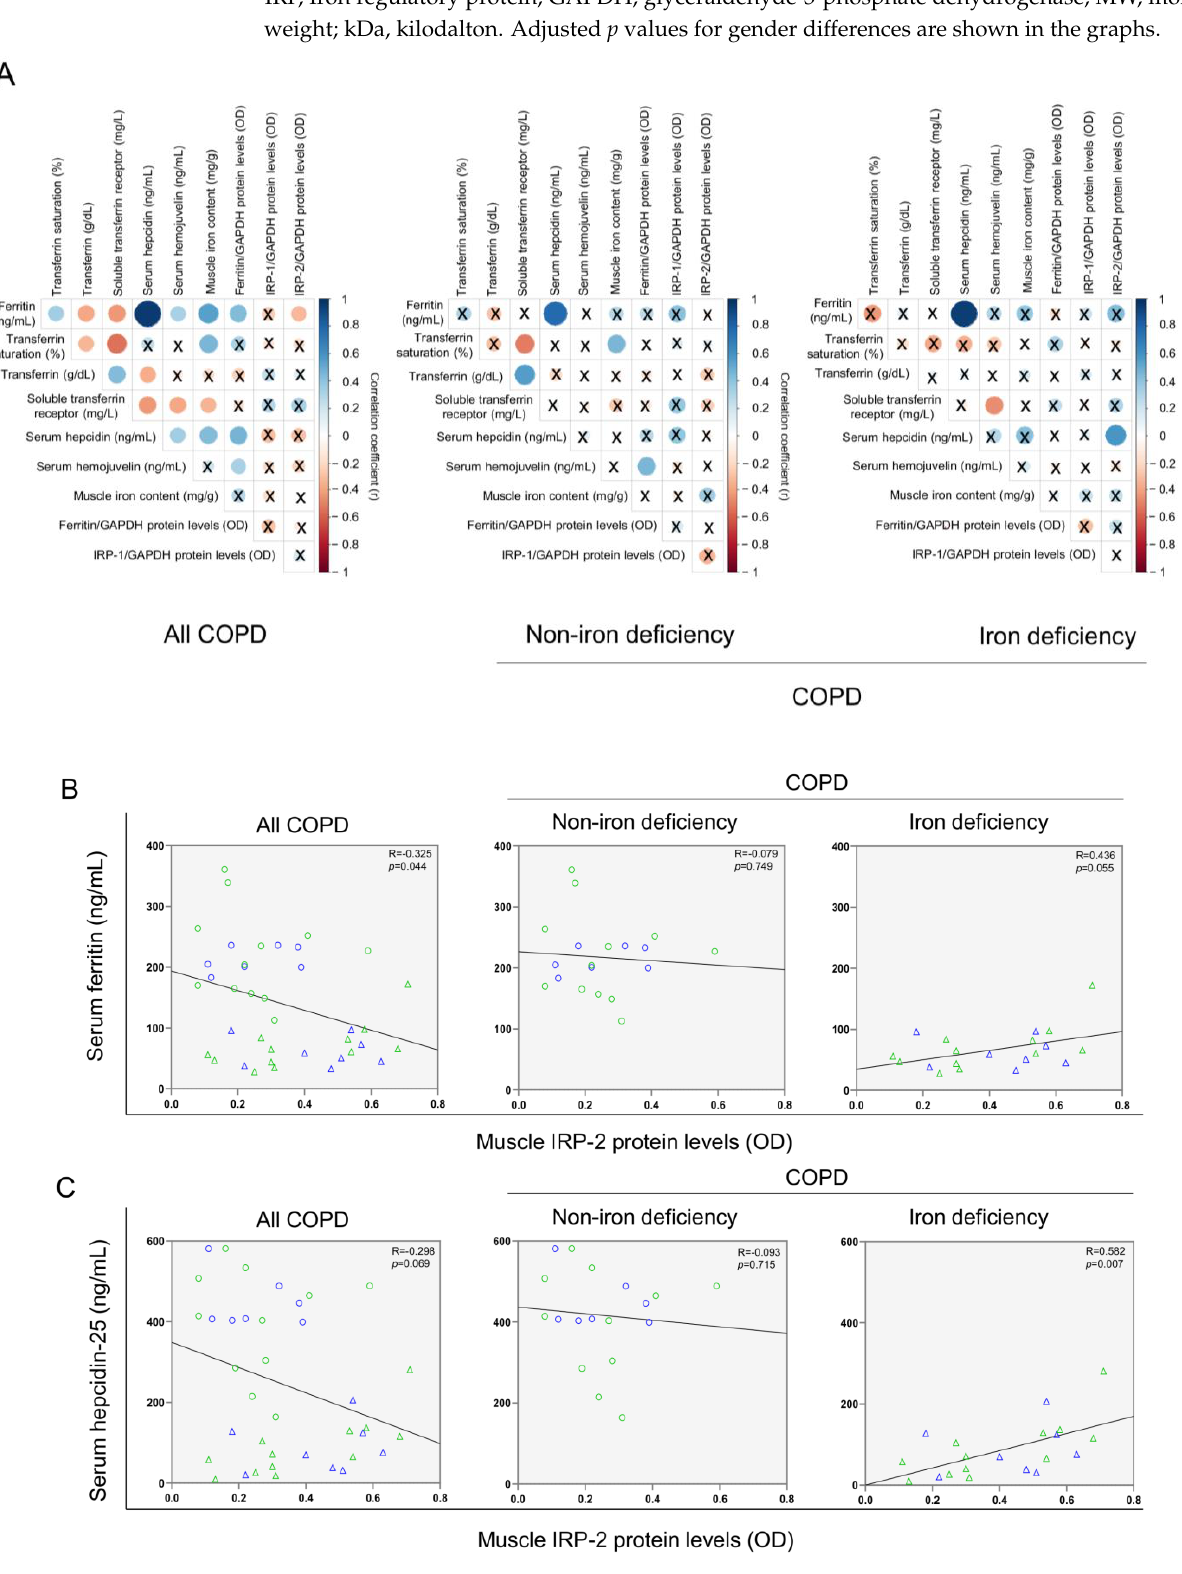
Figure 9. Correlation matrix of the blood and muscle iron metabolism parameters in all COPD